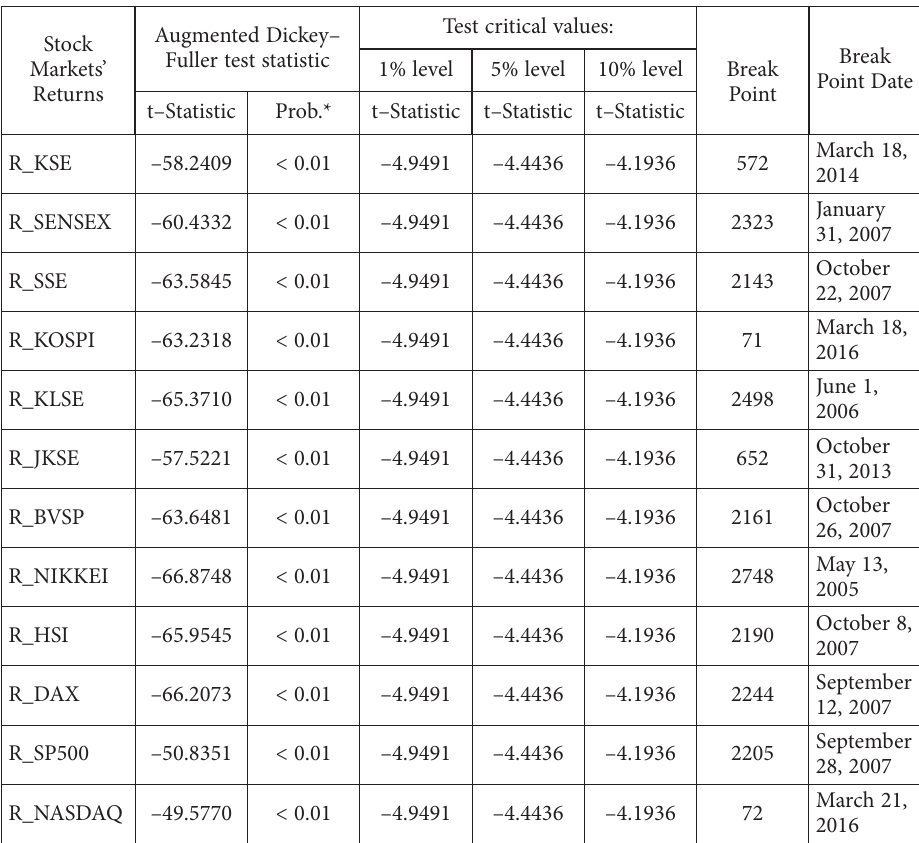
Table 5. Stationary test results for stock markets with